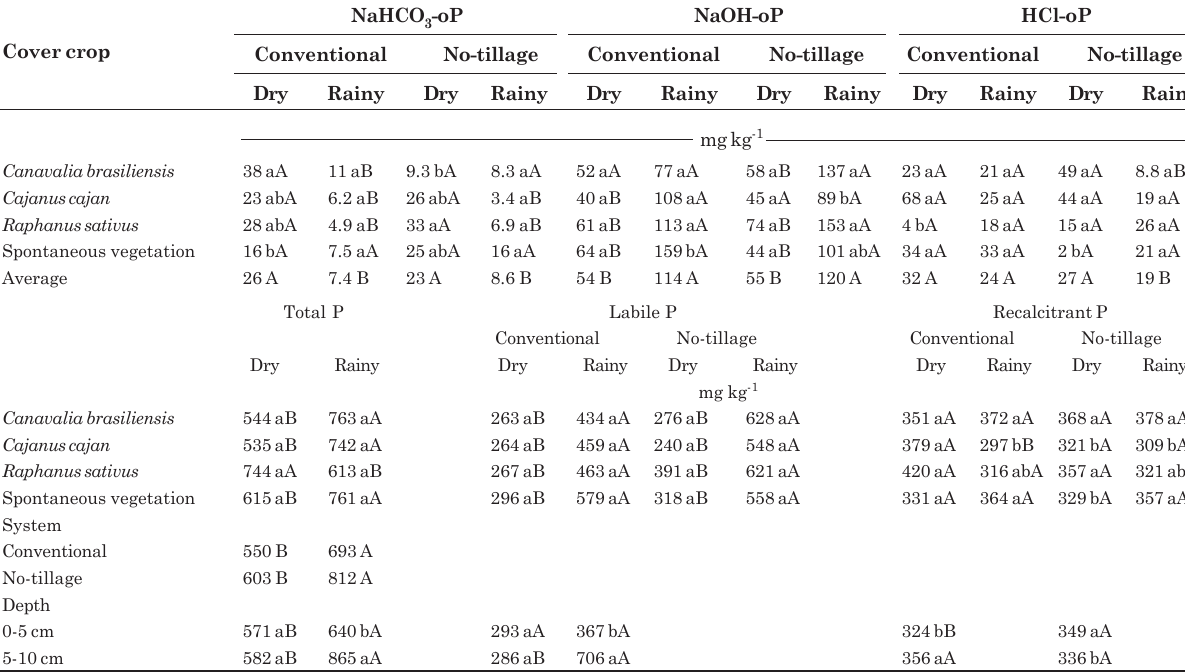
Table 3. Concentrations of the organic, labile, recalcitrant fractions and total phosphorus in a soil with cover crops under conventional and no-tillage systems over two seasons (dry and